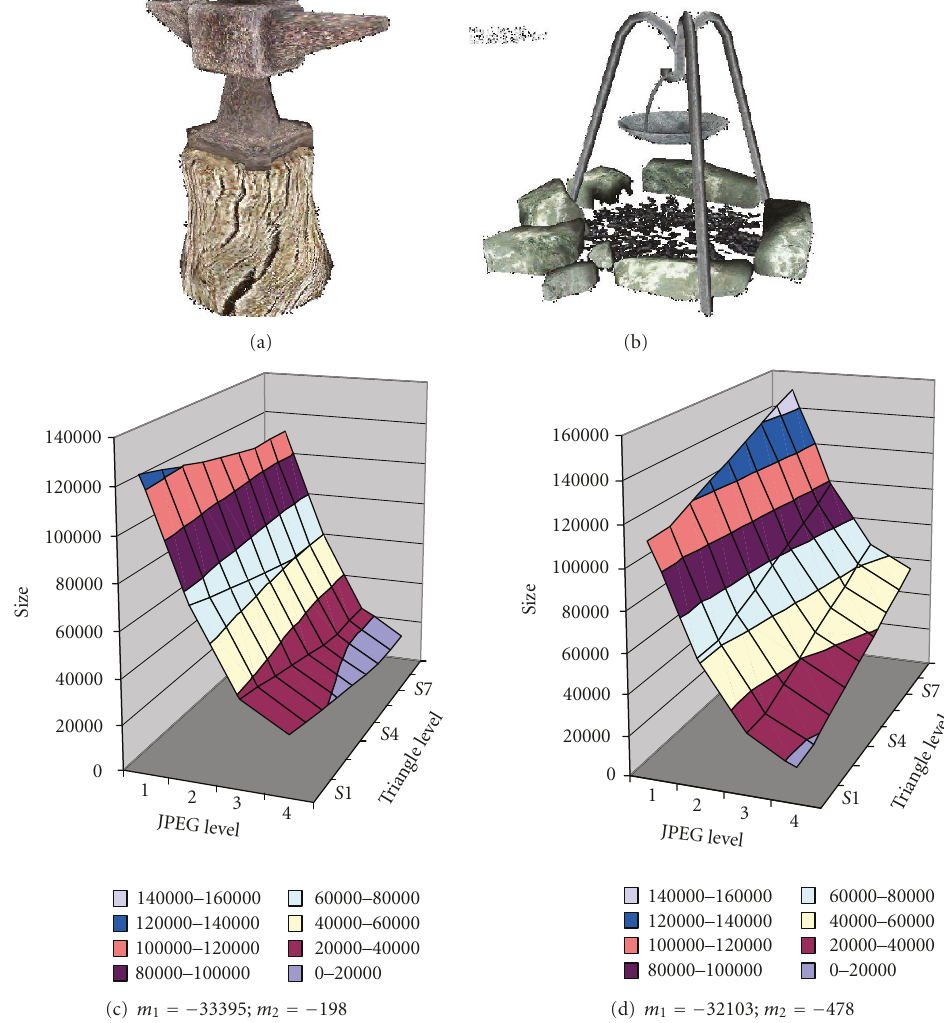
Figure 7: Bilinear dependency of MPEG-4 file size on 2D texture and 3D mesh